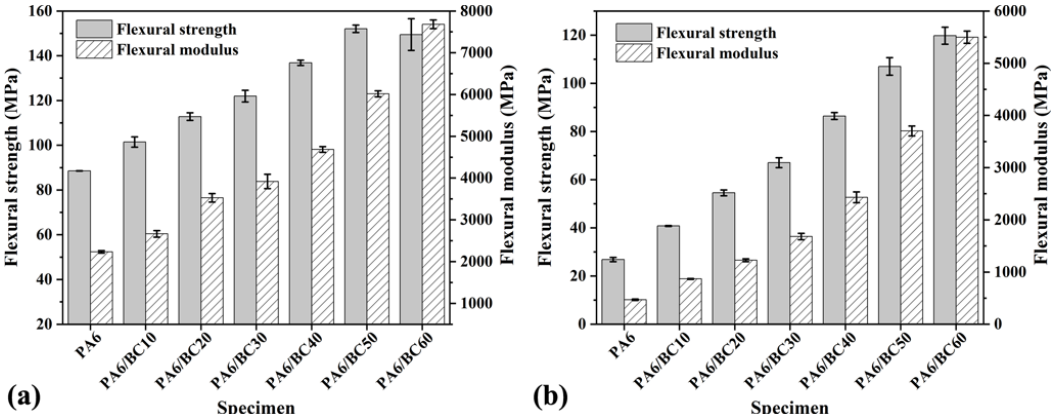
Figure 5. Flexural properties of PA6 / BC composites with di ff erent BC contents, ( a ) no water treatment, ( b ) water treatment.